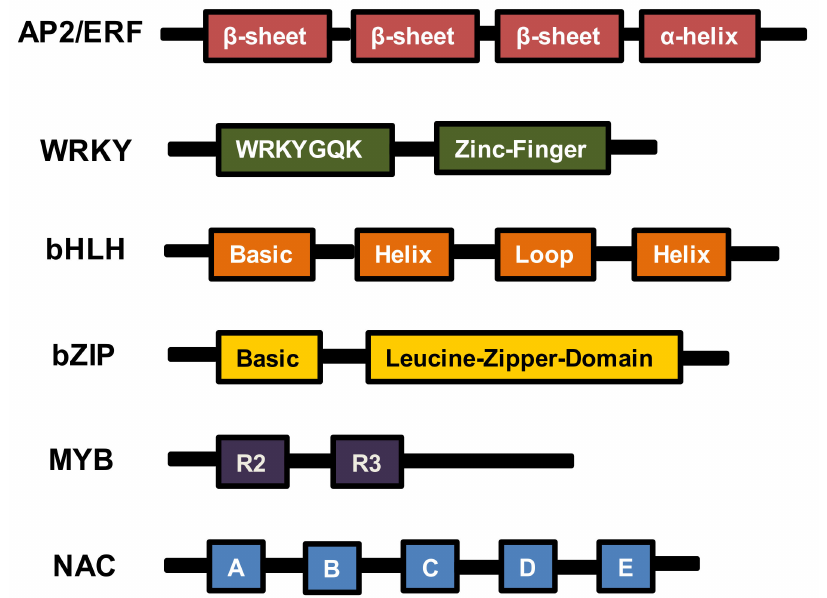
Figure 1. Conserved structures and domains of transcription factors in this